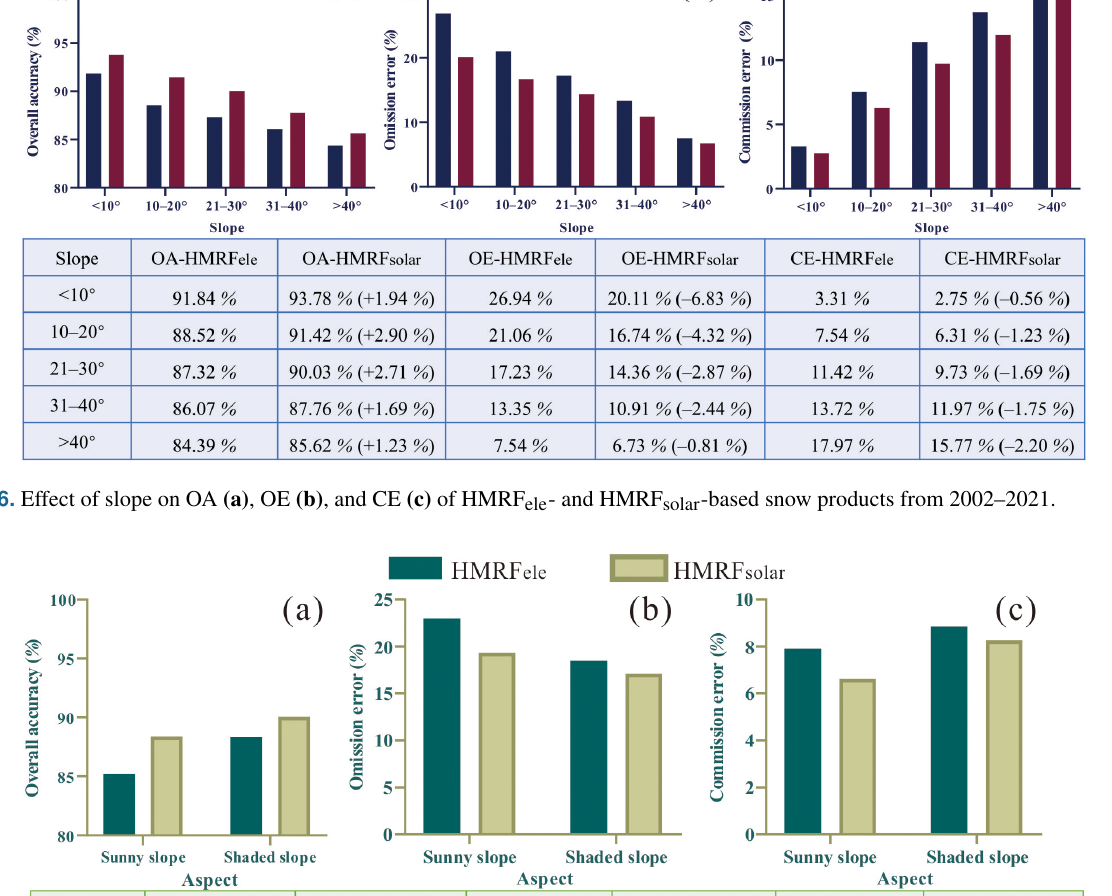
elevation used in the original HMRF ele modeling technique (Huang et al., 2018). The calculated optimal parameters used in Eq. (1) could reflect the importance of each energy to a cer- tain extent. The optimal parameters of the HMRF solar -based products for spectral, spatial–temporal, and environmental information were 0.117, 1.294, and 0.532, respectively, while that of the original HMRF ele -based products were 0.338, 1.419, and 0.576, respectively. The proportion of environ- mental information of HMRF solar -based products (27.37 %) were higher than that of HMRF ele -based products (24.70 %), which shows the improvement of HMRF solar -based prod- ucts over complex terrain. Moreover, Fig. 8a shows a true- color Sentinel-2B image. Figure 8b, c, and d show the orig- inal MODIS, HMRF ele - and HMRF solar -based snow cover products, respectively, on 31 October 2018. The examples in